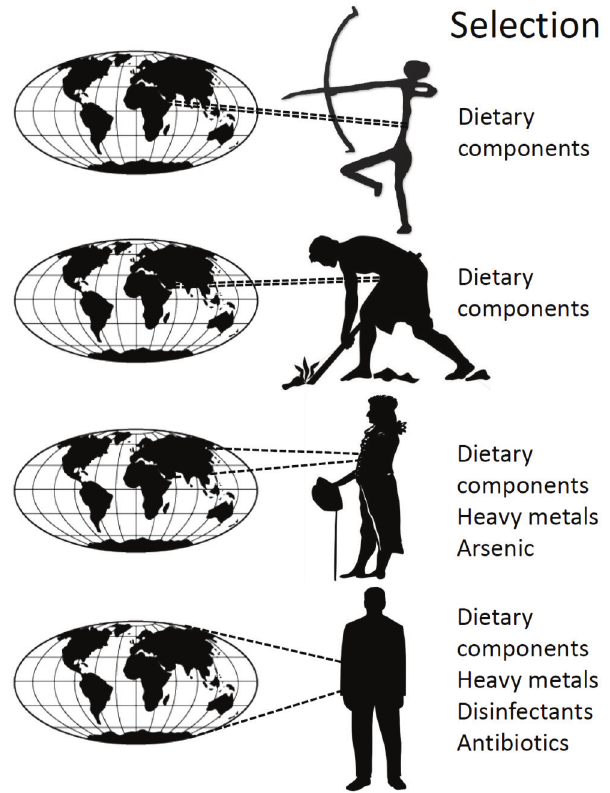
Figure 1. Schematic history of selective forces acting on the human microbiome and microbiota. As human populations moved from hunter-gatherer, to agrarian communities, to the industrial revolution, to modern civilization (vertical dimension), the selective forces on the microbiota and microbiome have changed. Early selection was mainly driven by ability to metabolize dietary components, while more recently, strong selective agents such as heavy metals and antimicrobial agents have become increasingly important. In addition, the potential sources of both microbiota and microbiome components (species and genes) have broadened as mass movement of materials and organisms became a feature of a globalized